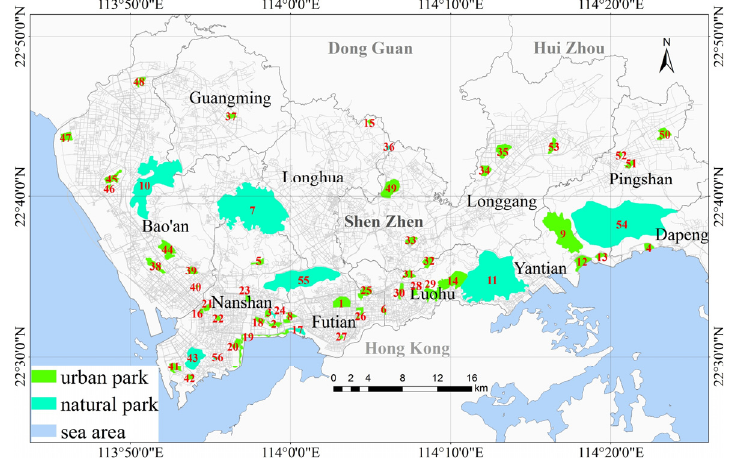
Figure 1. Distribution of parks in the study area. The numbers represent the selected parks listed in Table 1. City boundary data are from RESDC [40]. For clarity, Dapeng District is not fully included in the map. Table 1. Average number of daily trips in three time periods for different age groups (persons/day).